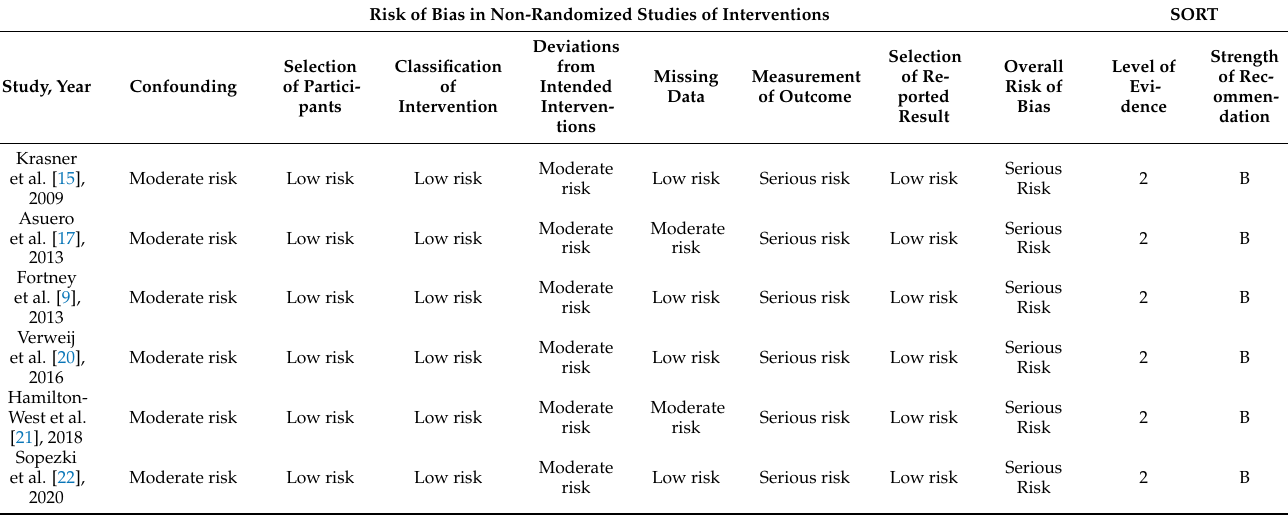
Table 3. Risk of bias, level of evidence, and strength of recommendation for non-randomized controlled trials. Risk of Bias in Non-Randomized Studies of Interventions